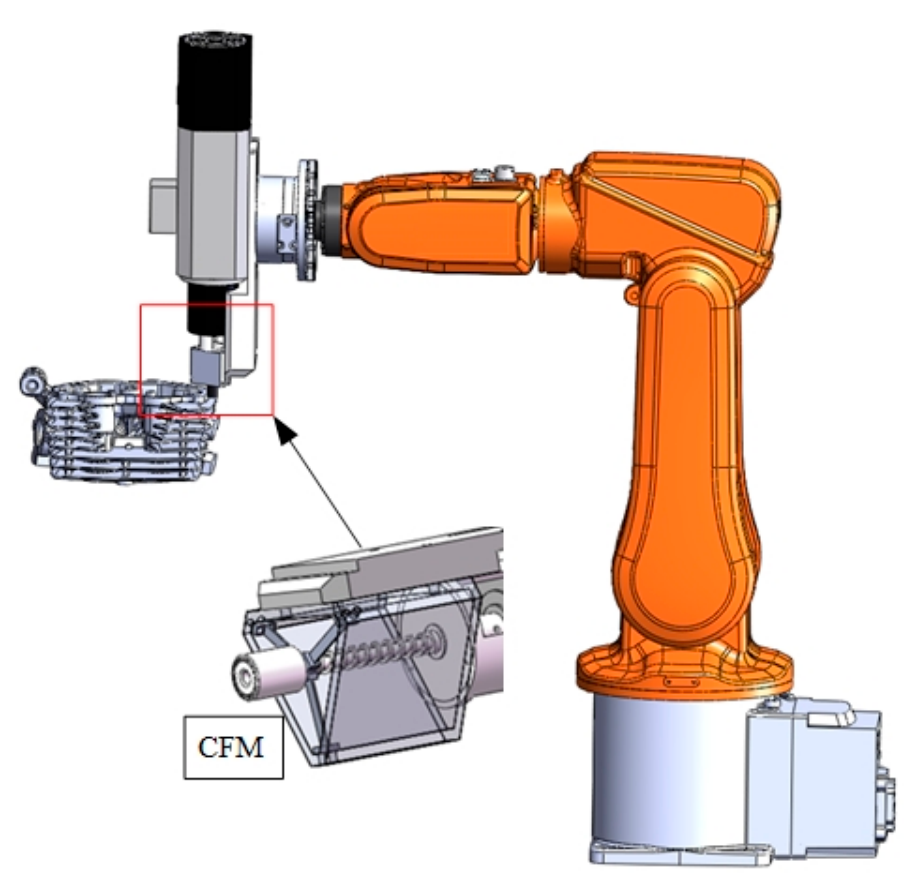
Figure 7. Autonomous sanding scenario using CFM end-effectors.